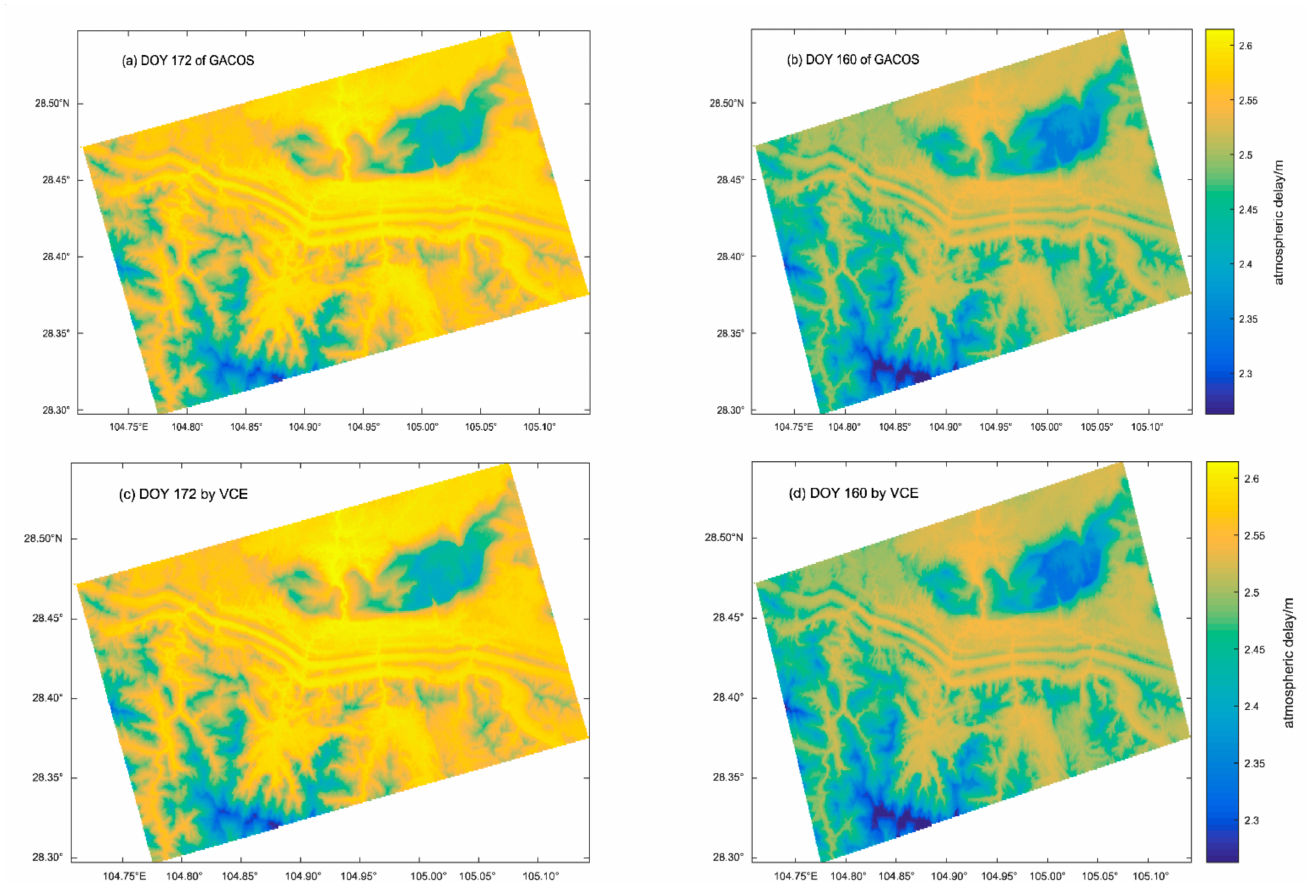
Figure 3. Daily atmospheric delay obtained from different models: ( a ) the atmospheric delay of the InSAR signals on DOY 172 according to the GACOS model; ( b ) the atmospheric delay of the InSAR signals on DOY 160 according to the GACOS model; ( c ) the atmospheric delay of the InSAR signals on DOY 172 according to the variance component weighting model; and ( d ) the atmospheric delay of the InSAR signals on DOY 160 according to the variance component weighting model. The color − coded strips represent the calculated ZTD; the vertical axis and horizontal axis represent the north latitudinal range and the east longitudinal range of the study area,